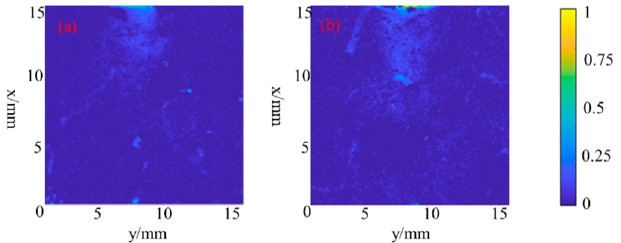
Figure 5. The cavitation intensity distribution of acoustic cavitation ( a ) 250 W ( b ) 500 W.